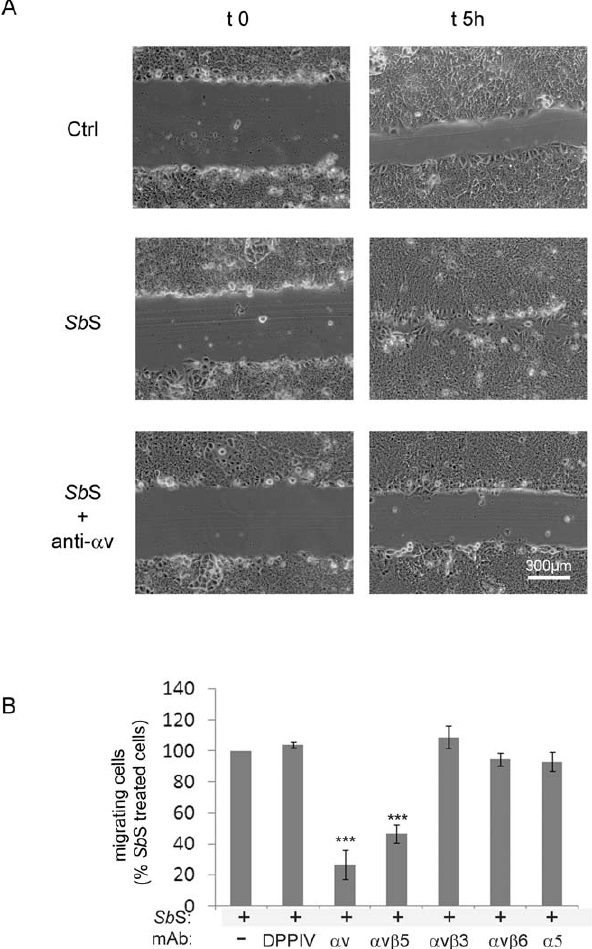
Figure 1. a v b 5 integrin is required for Sb S-stimulated cell restitution. (A) Polarized HCT-8/E11 cell monolayers were pretreated without or with 10 m g/ml of an anti- a v integrin mAb (anti- a v) for 1 h. Cell monolayers were then wounded as described in Methods and incubated for 5 h in the absence (ctrl) or presence of Sb S in a medium either containing anti- a v integrin mAb or not. Phase contrast images were acquired at the indicated times. Data shown are from a representative experiment out of 3 performed. Scale bar: 300 m m. (B) HCT-8/E11 cell monolayers were wounded and incubated with Sb S. The monolayers were further incubated without (-) or with the following function-blocking anti-mAbs 1 h before wounding and during cell migration: a vintegrin ( a v), a v b 3 integrin ( a v b 3), a v b 5 integrin ( a v b 5), or a v b 6 integrin ( a v b 6). Wound closure was determined as described in Methods. Results are expressed as the percentage of cell migration compared to Sb S-treated cells without mAbs. Data represent the mean + SD of 5 separate experiments. Rat-anti DPP IV (DPPIV) and mouse anti- a 5 subunit ( a 5) were used as isotypic Abs controls. *** P , 0.001.